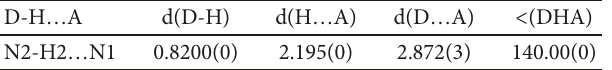
Table 4: Hydrogen-bonding geometry for 5 (Å and ° ).